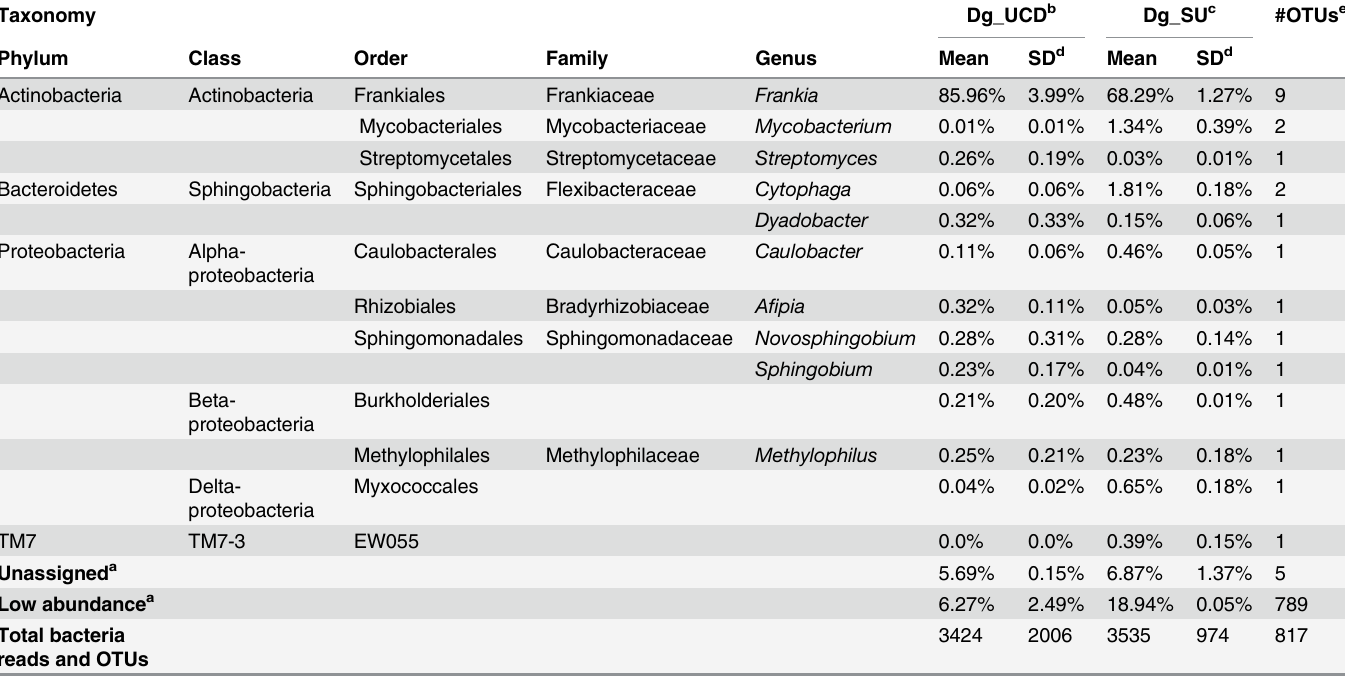
Table 5. Processed bacterial sequences and taxonomy assignments by sample source.